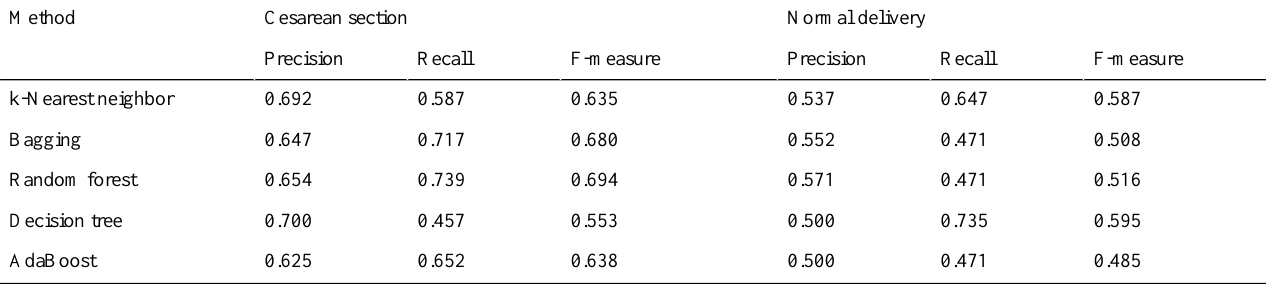
Table 3. Precision, recall, and F-measure of the models trained with enriched data.